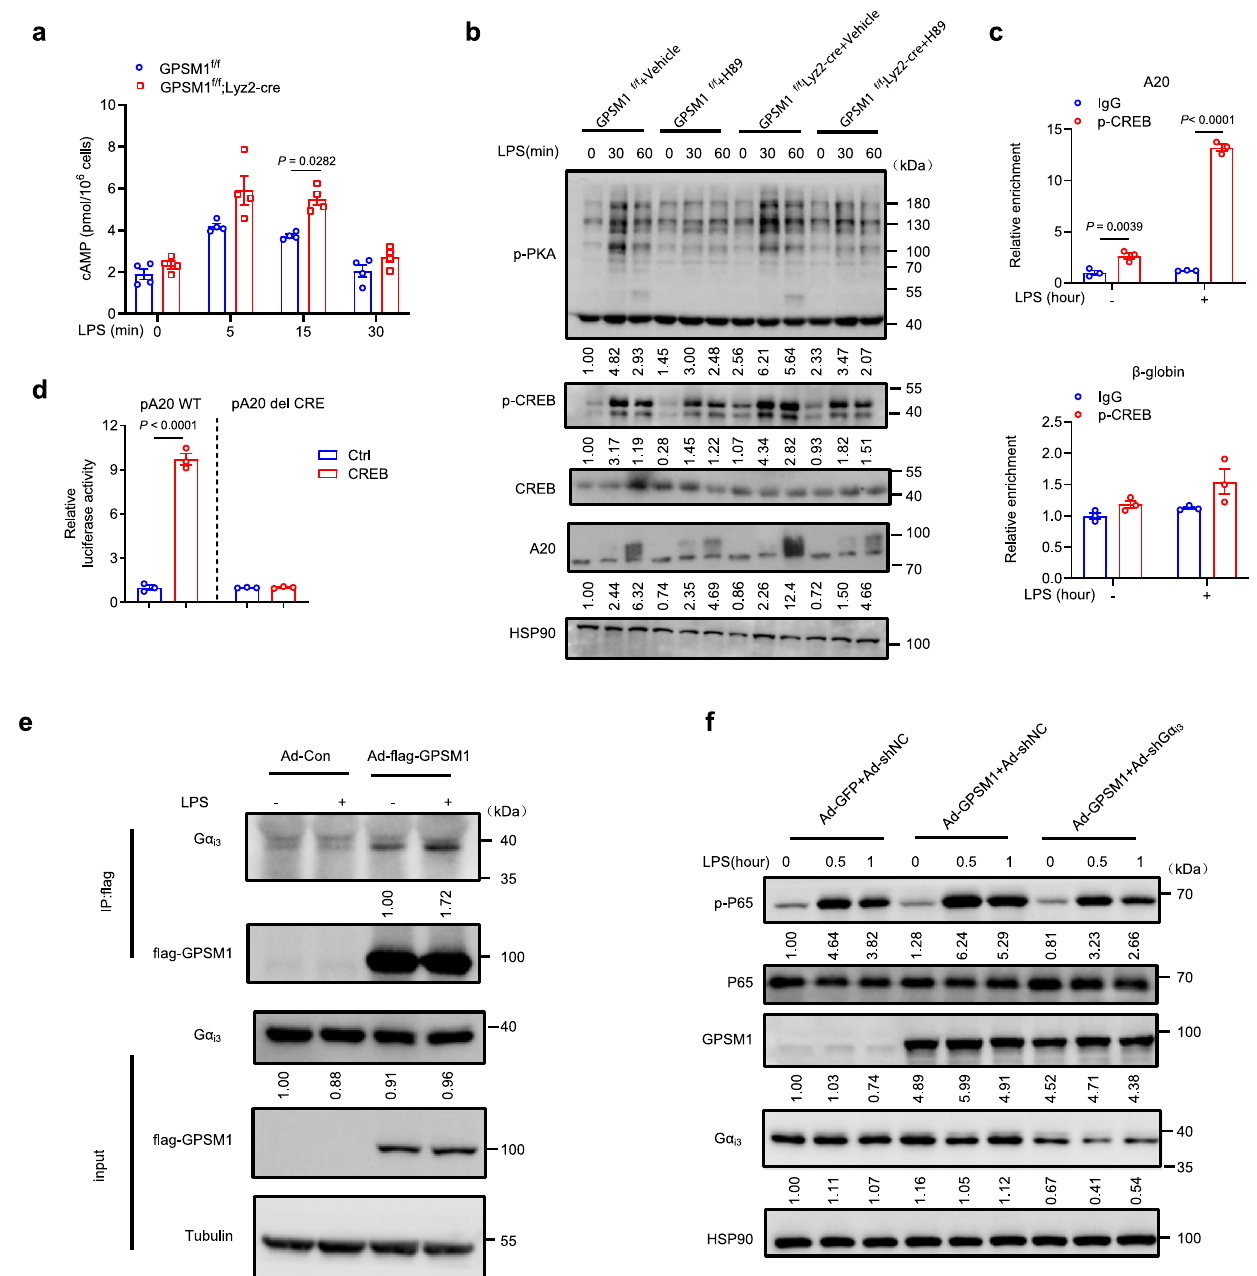
Fig.7|GPSM1de fi ciency-inducedTNFAIP3upregulationisviatheG α i3/cAMP/ PKA/CREB axis. BMDMs from GPSM1 f/f ; Lyz2 -cre and GPSM1 f/f mice were treated with200ng/mlLPSorvehiclecontrolforindicatedtimes. a cAMPlevelsinBMDMs treated with LPS ( n =4 independent samples per group). b GPSM1 f/f and GPSM1 f/f ; Lyz2 -creBMDMswerepre-treatedwithH-89(50 μ M)orvehiclefor30minandthen stimulated with LPS for additional indicated times. Immunoblots for p-PKA sub- strate, p-CREB, CREB and A20 in BMDMs. c ChIP-qPCR of A20 in BMDMs with or withoutLPSstimulation( n =3independentsamplespercondition). β